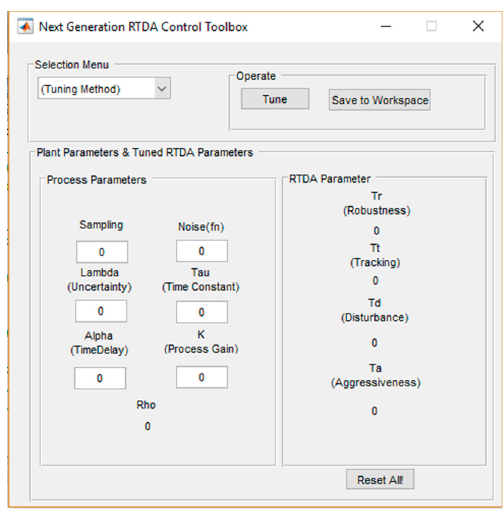
Figure 4. For the RTD-A controller tuning tool.